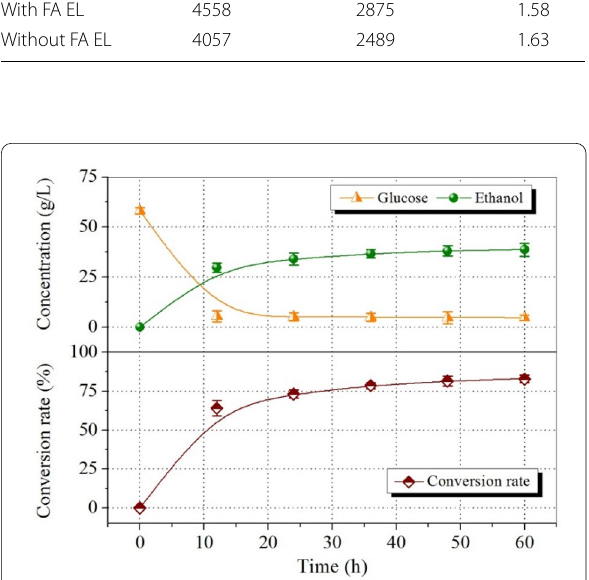
Fig. 8 Concentrations of glucose and ethanol and the ethanol yield in the Q-SSF process